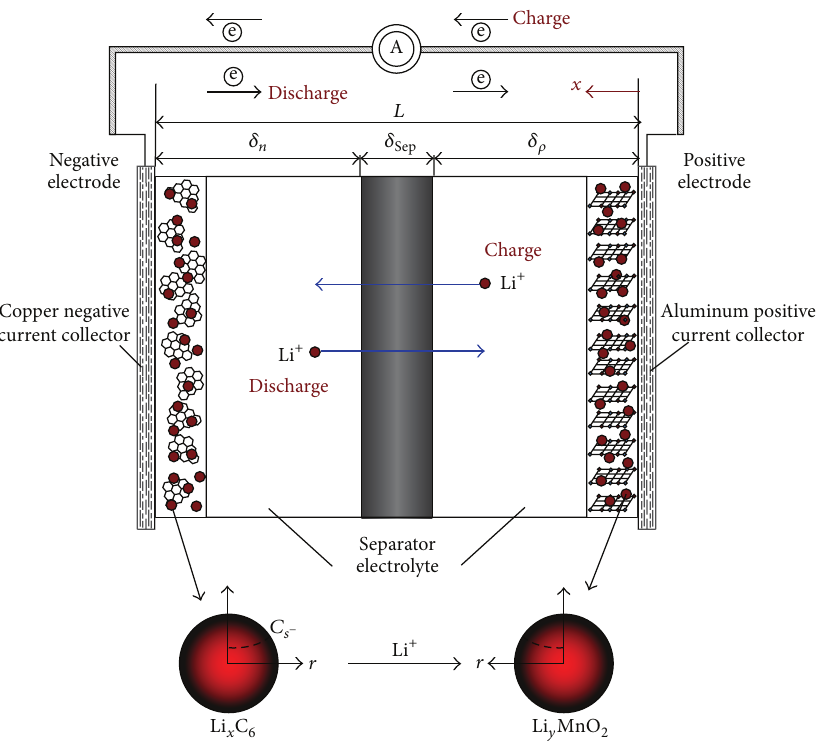
Figure 1: Schematic illustration of a Li-ion battery during